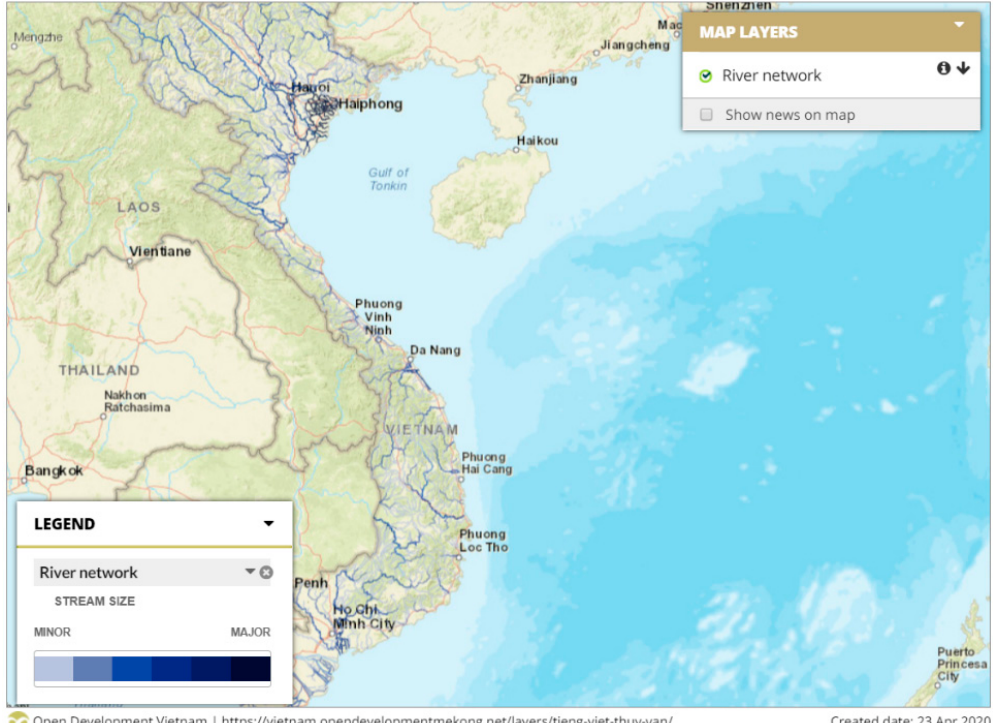
Figure 4. Vietnam’s rivers network [29].